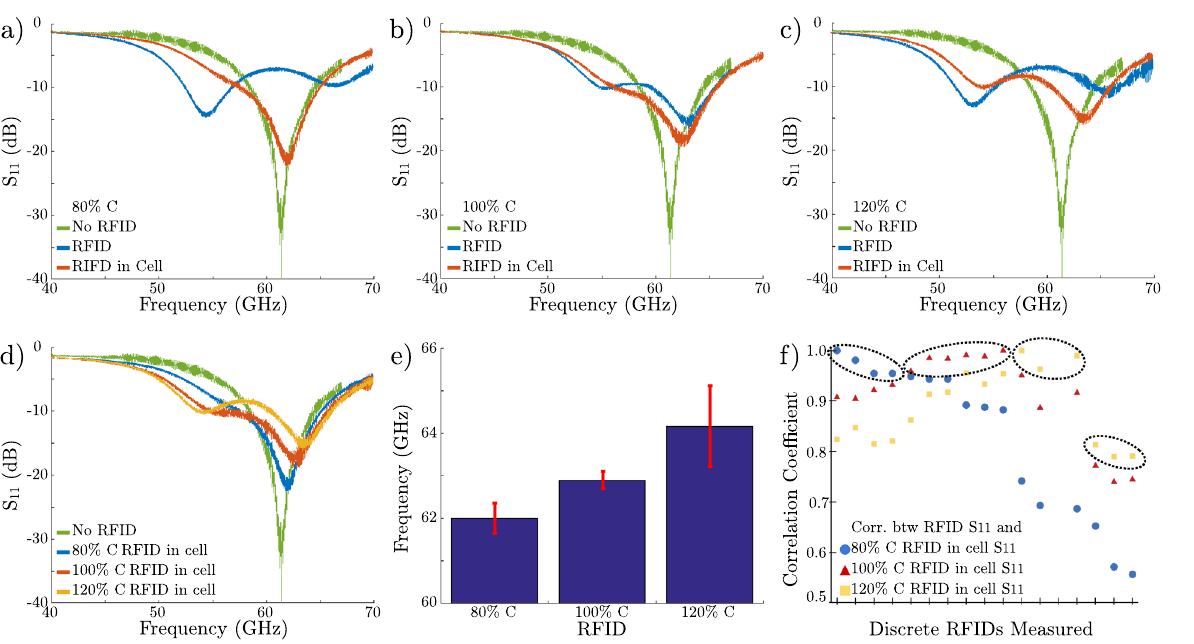
Figure 5. ( a – c ) Electrical response of the standalone transceiver (green) and the three different classes of RFIDs (80%C, 100%C, and 120%C) stored in isopropyl alcohol (blue) and 24 h after completing the uptake process (red). ( d ) A direct comparison of the electrical responses of the three batches of intracellular RFIDs 24 h after completing the uptake process. The different devices show different electrical signatures with different resonant frequencies. ( e ) Mean and standard deviation of the resonant frequency of a sample of 5 devices for each capacitor value RFID. ( f ) Given a mixed batch of RFIDs with all three types of devices, individual RFIDs can be categorized according to the correlation match between the S 11 response and the expected RFID S 11 responses. The x-axis designates individual RFID measurements and the y-axis represents the correlation coefficient calculated from the measurements. Note that high correlation (circled) indicates the measured RFID’s most probable capacitance and corresponding design, enabling us to identify individual RFID